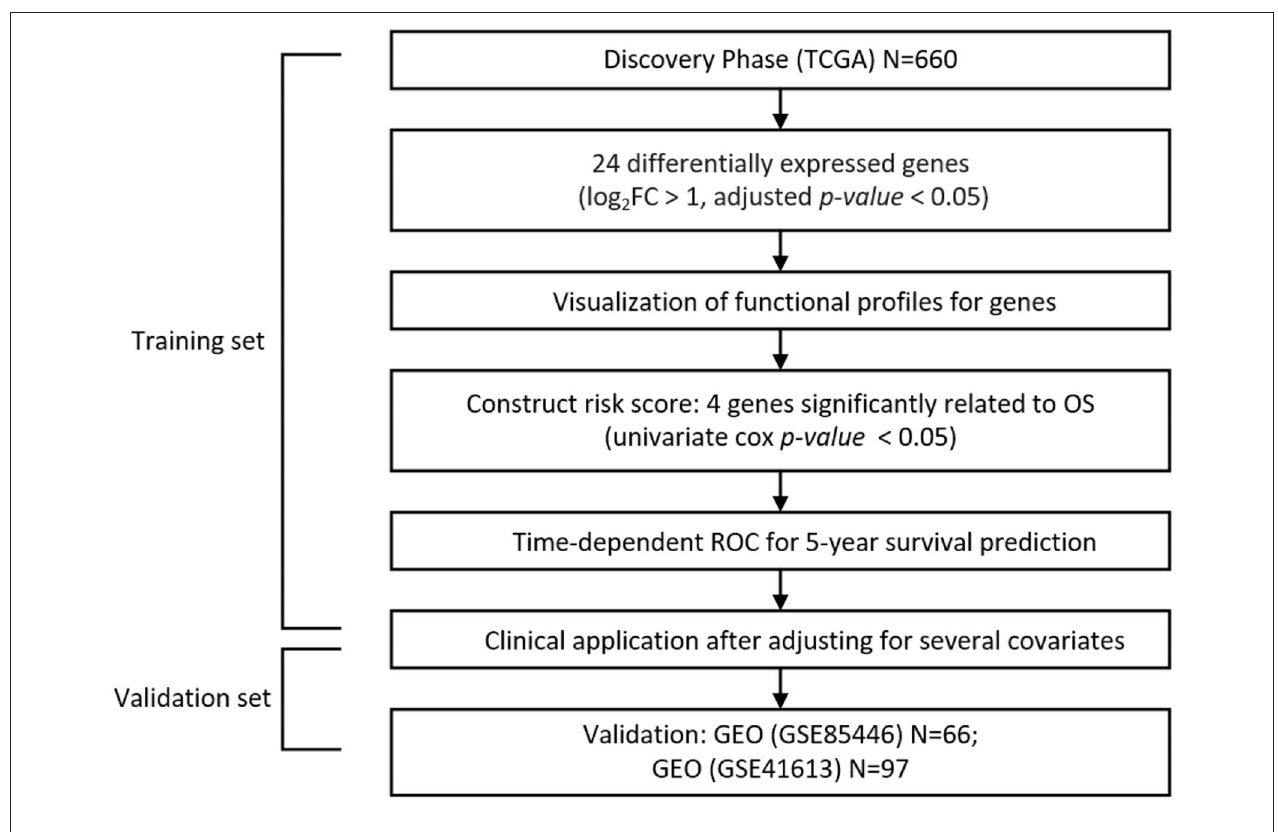
FIGURE 1 | Flow chart indicating the study design of the present work.